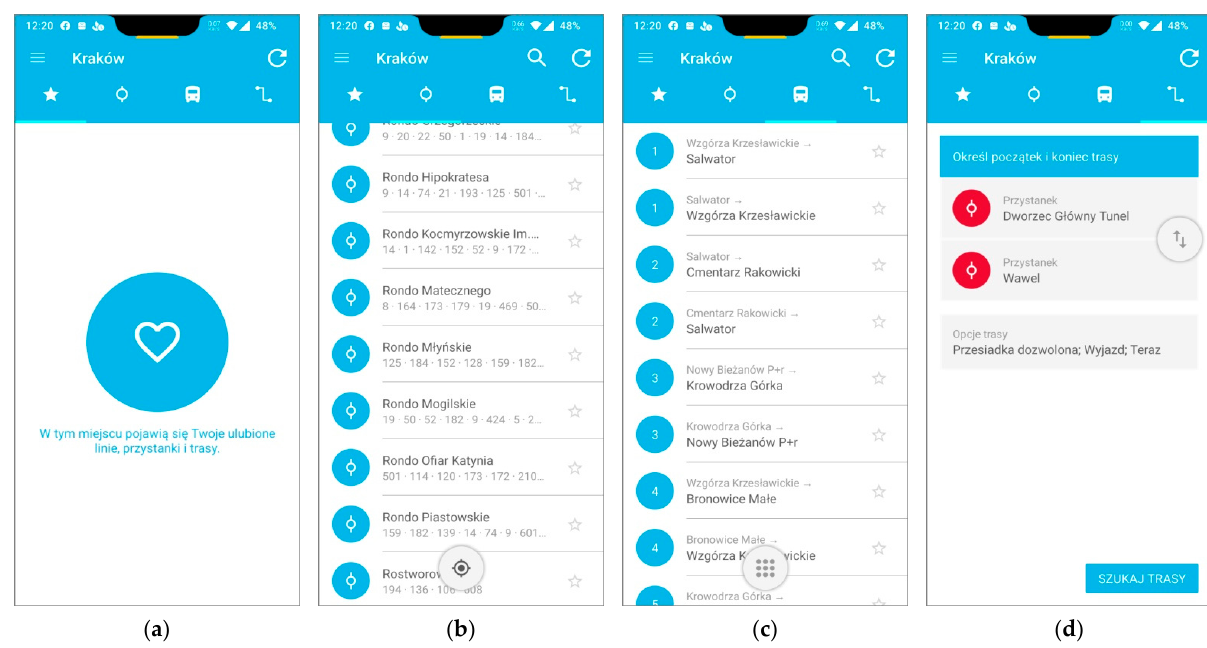
Figure 9. Overview of the four basic tabs of the Transportoid application: ( a ) “Favourites”; ( b ) “Timetables”; ( c ) “Lines”; ( d )